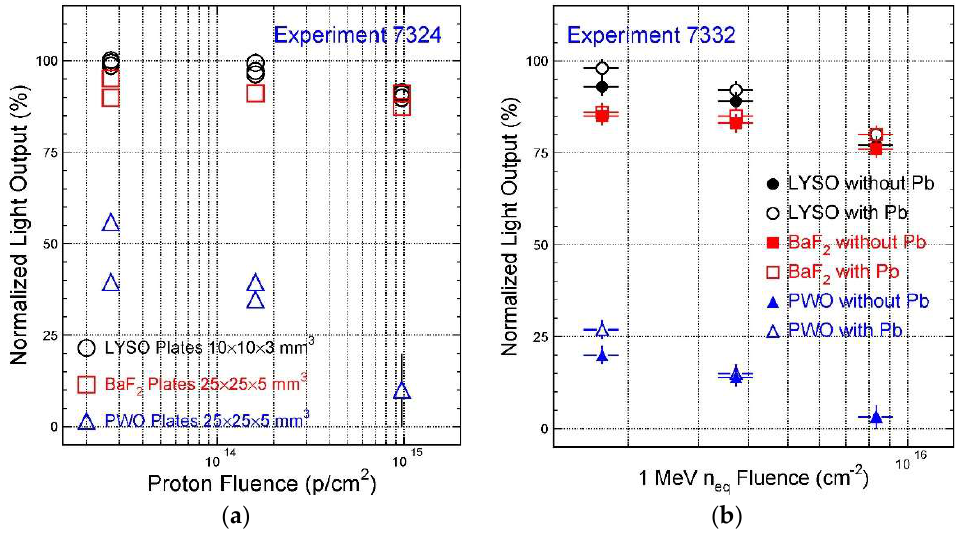
Figure 6. The LO values normalized before irradiation are shown as a function of ( a ) the proton fluence [28] and ( b ) the one MeV equivalent neutron fluence [32] for LYSO, BaF 2 , and PWO plates irradiated in the proton experiment 7324 and the neutron experiment 7332, respectively.